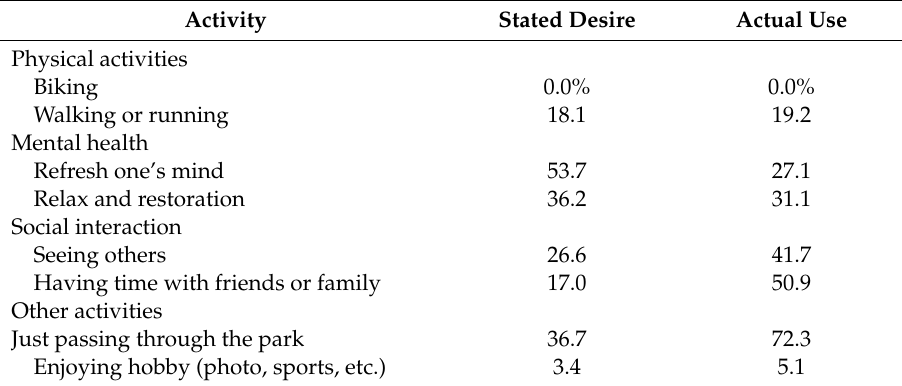
Table 4. Motivation and the actual activities in the